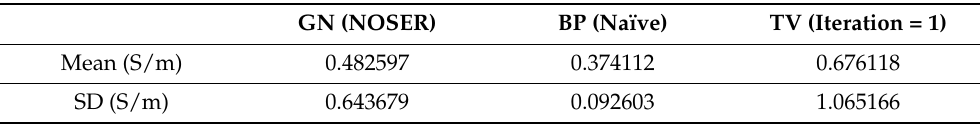
Figure 22. ( a ) A carrot slice at the centre of the EIT domain. The corresponding reconstructed images for different inverse solvers of ( b ) GN (NOSER), ( c ) BP (Naive), ( d ) TV (Iteration = 1), and ( e ) TV (Iterations = 2) at 80 kHz, 1 mA, and 2 Vpp excitation. Overall, GN: NOSER performed well considering λ = 0.17, a better shape and size of the carrot were reconstructed with less noise. Table 1. Calculated mean and standard deviation (SD) of obtained changes of conductivity by varying inverse solvers considering a carrot slice in the EIT domain.